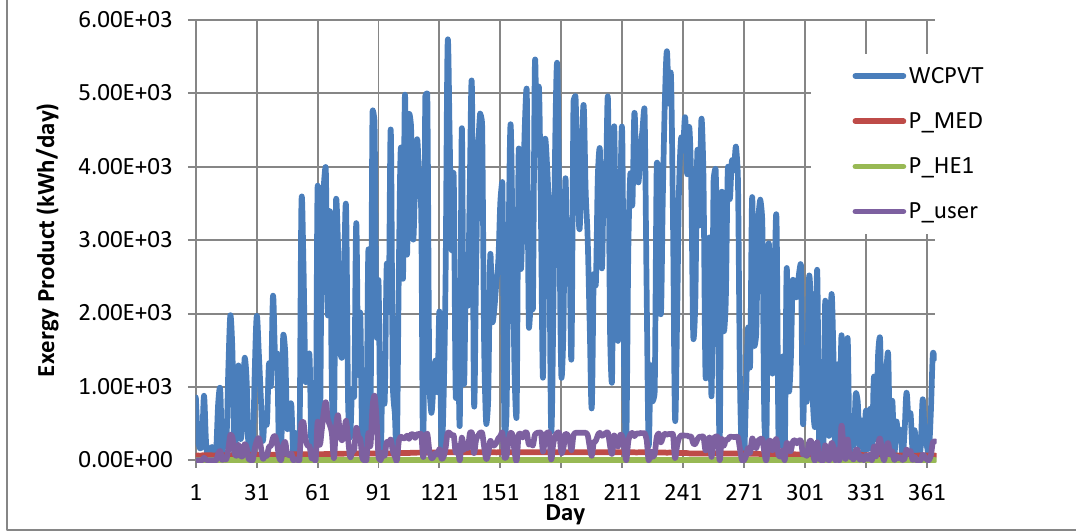
Figure 4. Daily exergy